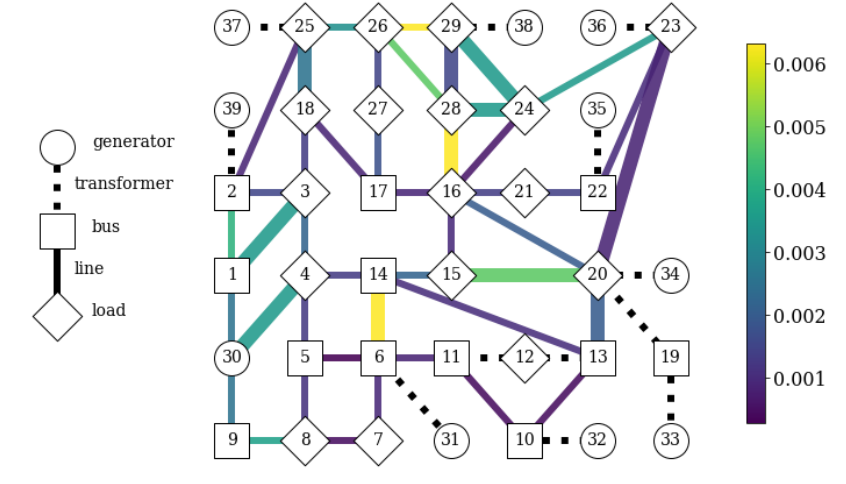
Figure 4. The schematic graph of the IEEE39 network with two legends: left showing symbols used in the graph and the right with N-1 fault probabilities obtained by utilizing the historical data published by PSE (Polish TSO). Nodes are depicted by squares (zero-load buses), diamonds (load buses) and circles (generators, apart from no. 30 representing an interconnection with a bigger system). The 10 transmission lines added by the authors are shown as